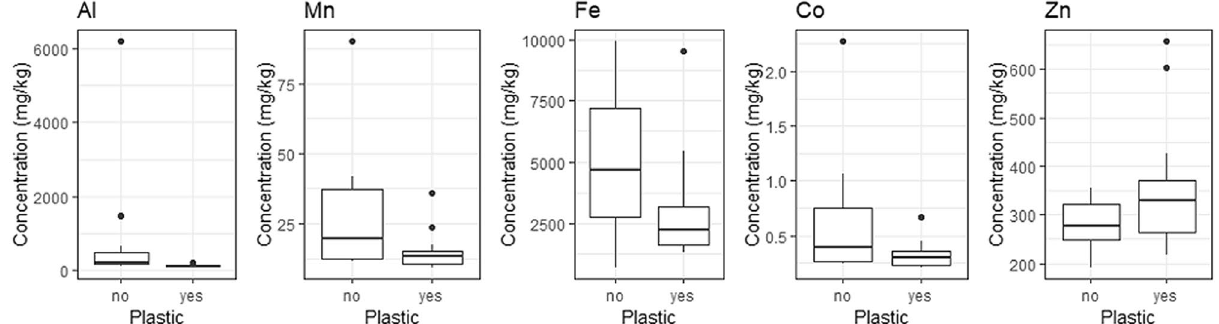
Figure 3. Liver concentration of Al, Mn, Fe, Co, and Zn (mg/kg of dry mass) in slender-billed prions (n = 25) showed significant differences between individuals that had not ingested (n = 11, left bars) or had ingested (n = 14, right bars) plastic at the time of death in emaciated condition during a “seabird wreck” in New Zealand, August 2016.